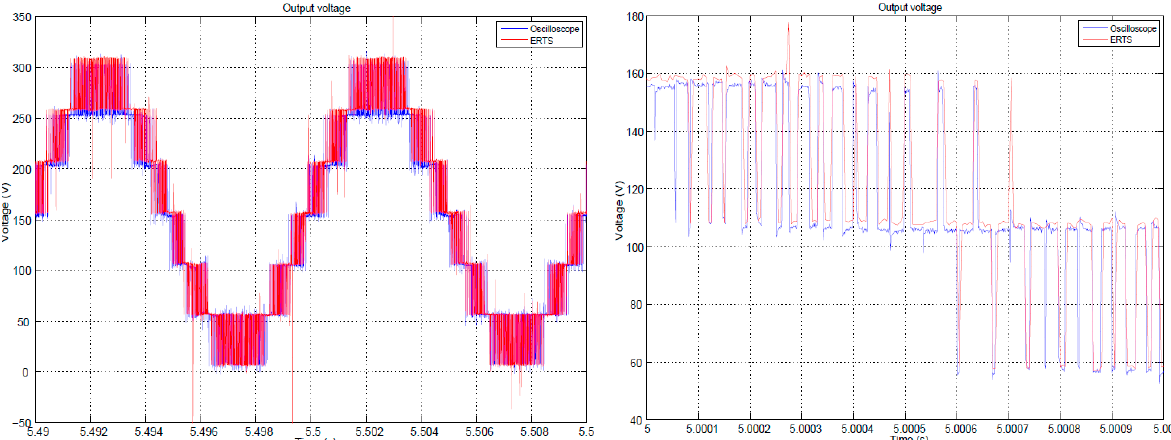
Figure 10. MMC output ac voltage reconstruction from the eRTS, during two periods ( left side) and inside shorter time window ( right side).